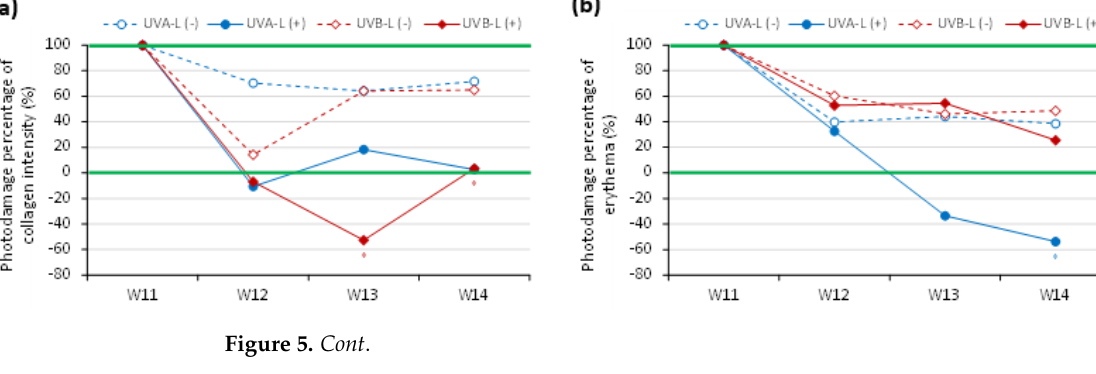
Figure 5. Photodamage percentile curve in UVA-/UVB-irradiated groups with spontaneous reversal (dotted lines) and laser-assisted reversal (solid lines). ( a ) collagen intensity, ( b ) erythema, ( c ) TEWL, and ( d ) epidermal thickening measured by OCT. 2.5. LIOB Generation Post-Picosecond Laser with Diffractive Lens Array in Nude Mice Despite Lack of Melanin The LIOB was traced using sequential OCT images immediately and 120 h after the initial laser therapy in both the UVA-L(+) and UVB-L(+) groups (Figure 6). The LIOB ap- peared as a round-to-oval intraepidermal hyporeflective vacuole on FFOCT, expanding to one-third to two-thirds of the epidermal thickness. The basement membrane (BM) re- mained intact. LIOB was still observed in the UVB-L(+) group 3 weeks after the third laser therapy (Figure 6i). The diameter of the LIOB in sequential images was measured, and the mean diameter of the LIOB in the UVB-L(+) group was 35.45 ± 1.74 μm, which was larger than that of the UVA-L(+) group (24.75 ± 5.36 μm). Microscopic epidermal necrotic debris (MENDS) was observed in the post-treatment zones as hyper-reflective stacks situated immediately inferior to and within the stratum corneum (Figure 6d).